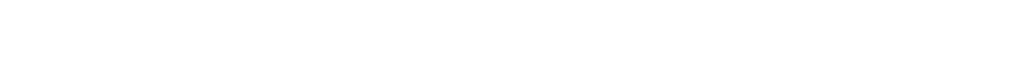
level of competencies, are more tangible and visible. Unlike the core personality, they are easier to